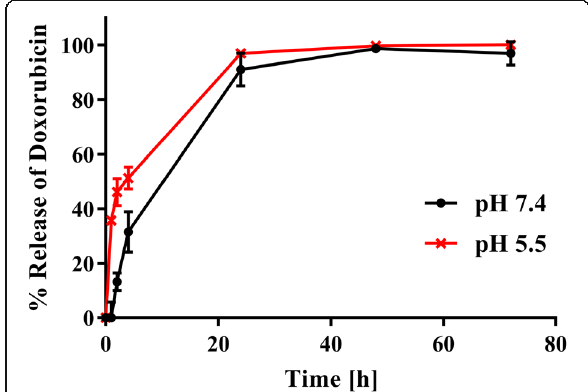
Fig. 3 Release of doxorubicin from nanoparticle solution shows controlled release over first 24 h in PBS, pH 7.4. Faster release of doxorubicin occurs at pH 5.5. Each point represents mean ±